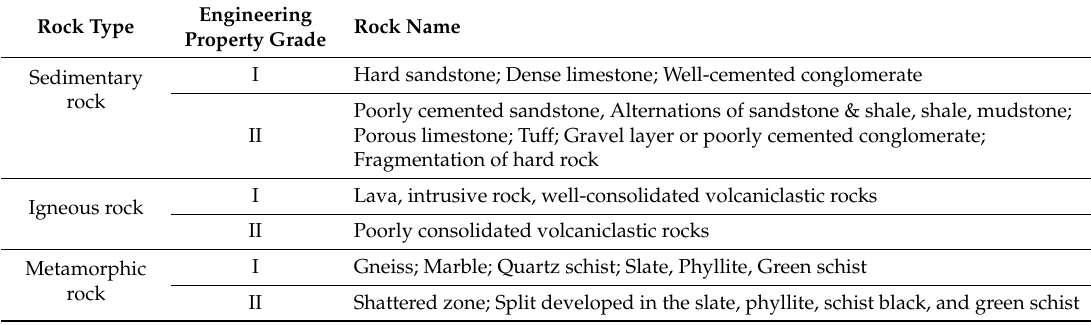
Table 2. Classification of engineering properties of rock mass.